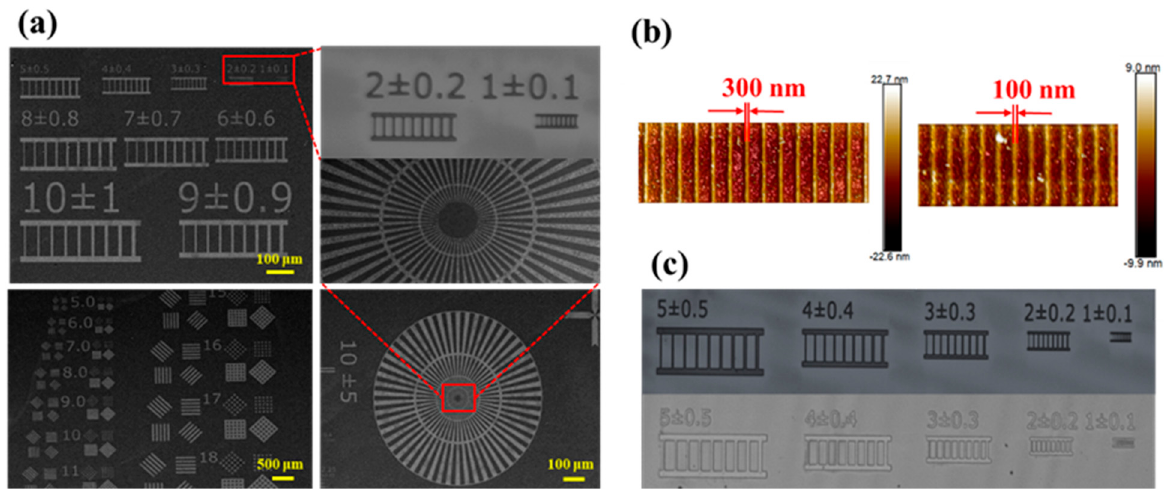
Figure 6. Lithographic patterning ( a ) exposed by different photomask; ( b ) EBL patterning; ( c ) developed by di ff erent developers.